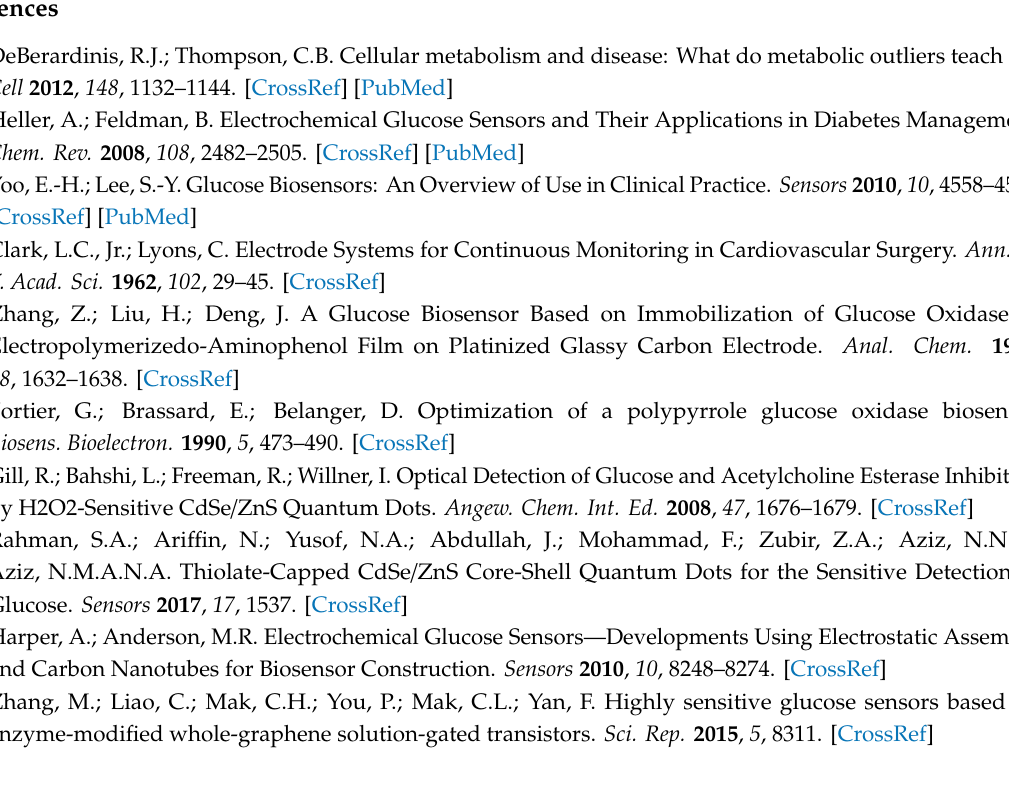
Figure S1: E ff ect of pH; Figure S2: Changes in the PL intensity; Tables S1–S2: Decay times and normalized pre-exponentials of QD nanoparticles; Figure S3: